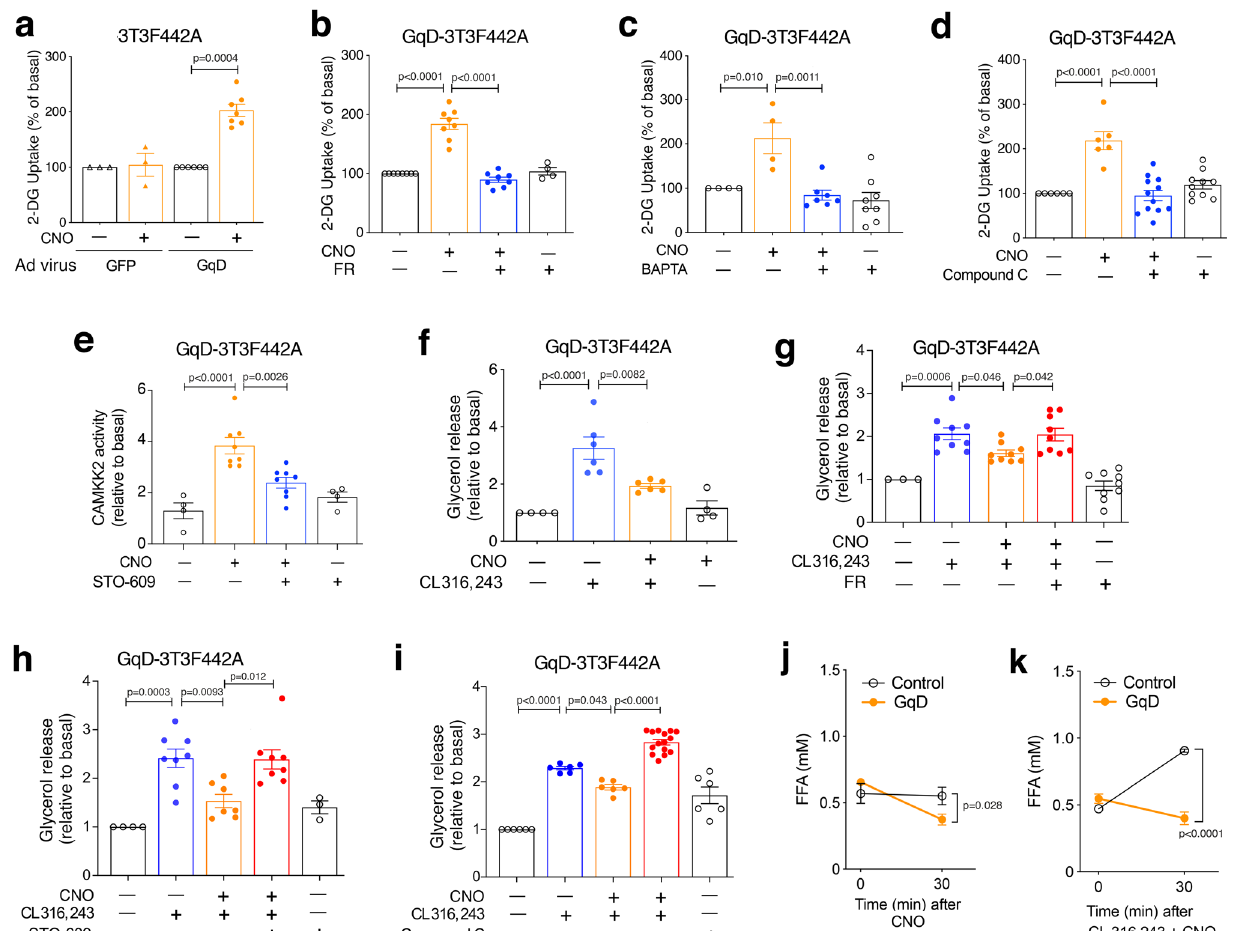
Fig. 4 Activation of G q signaling promotes glucose uptake and inhibits lipolysis in 3T3F442A adipocytes. a 14 C-2-Deoxy-D-glucose (2-DG) uptake in GFP- or GqD-expressing 3T3F442A cells after treatment with CNO (10 μ M). b – d , 2-DG uptake by CNO (10 μ M)-treated GqD-expressing 3T3F442A cells in the presence or absence of the G q/11 inhibitor FR900359 (FR; 1 μ M) ( b ), BAPTA (Ca 2 + chelator, 10 μ M) ( c ), or Compound C (AMPK inhibitor, 10 μ M) ( d ). e CAMKK2 activity of GqD-expressing 3T3F442A cells after treatment with CNO (10 μ M) and/or STO-609 (CAMKK2 inhibitor, 2 μ M). f Glycerol release after treatment of GqD-expressing 3T3F442A cells with CL316,243 (100 nM) in the presence or absence of CNO (10 μ M). g – i Glycerol release after treatment of GqD-expressing 3T3F442A cells with CL316,243 (100 nM), CNO (10 μ M), and various pharmacological inhibitors ( g : FR, 1 μ M; h : STO- 609, 2 μ M; i : Compound C, 10 μ M).). j Plasma FFA levels in adipo-GqD (GqD) and control mice before and after acute CNO injection (10 mg/kg i.p.) ( n = 4-8 per group). k Plasma FFA levels in adipo-GqD (GqD) and control mice before and after i.p. treatment with CL316,243 (0.1 μ g/kg) plus CNO (10 mg/kg) ( n = 8 per group). In ( a – i ), data were normalized relative to values obtained in the absence of any drugs. Data are presented as means ± s.e.m. of at least three independent experiments ( a – i ). a , j , k : two-tailed Student ’ s t -test; b – i : one-way ANOVA followed by Bonferroni ’ s post-hoc test). Source data are provided as a Source data fi